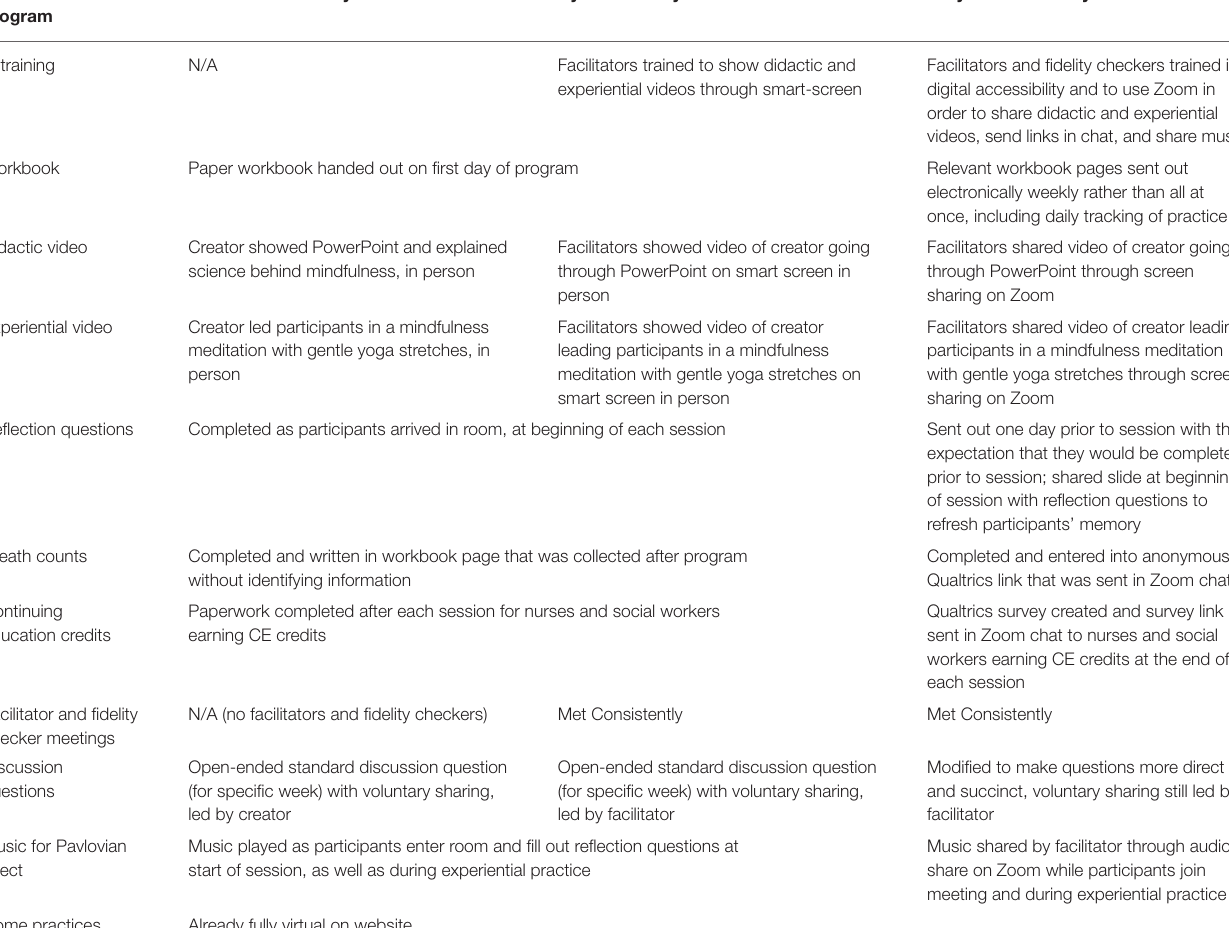
TABLE 1 | Changes made to accommodate virtual delivery of